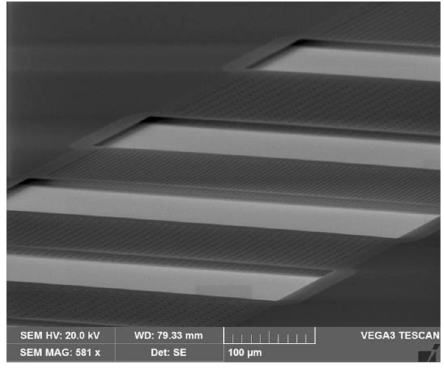
Figure 1. SEM image of CCFF perforated